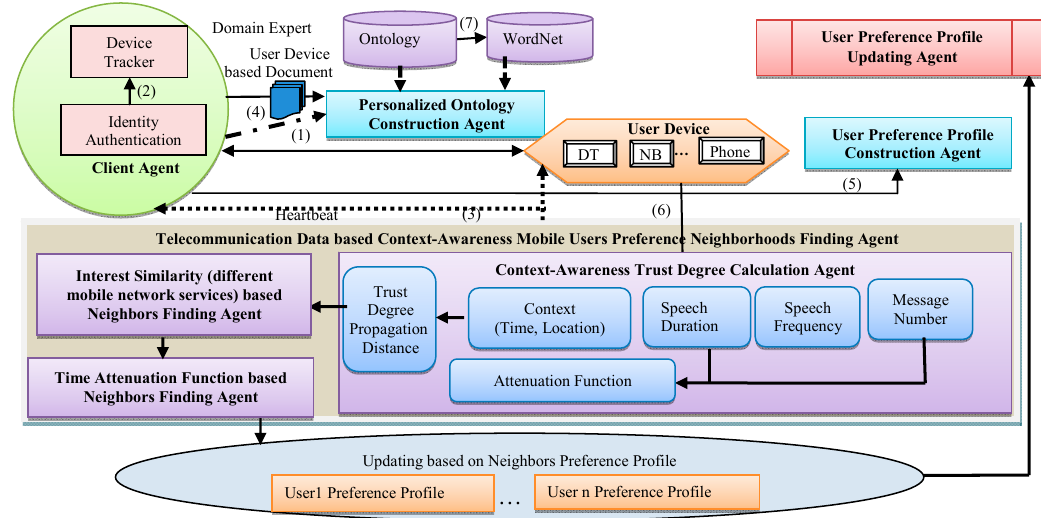
Figure 2. The framework of the proposed system.